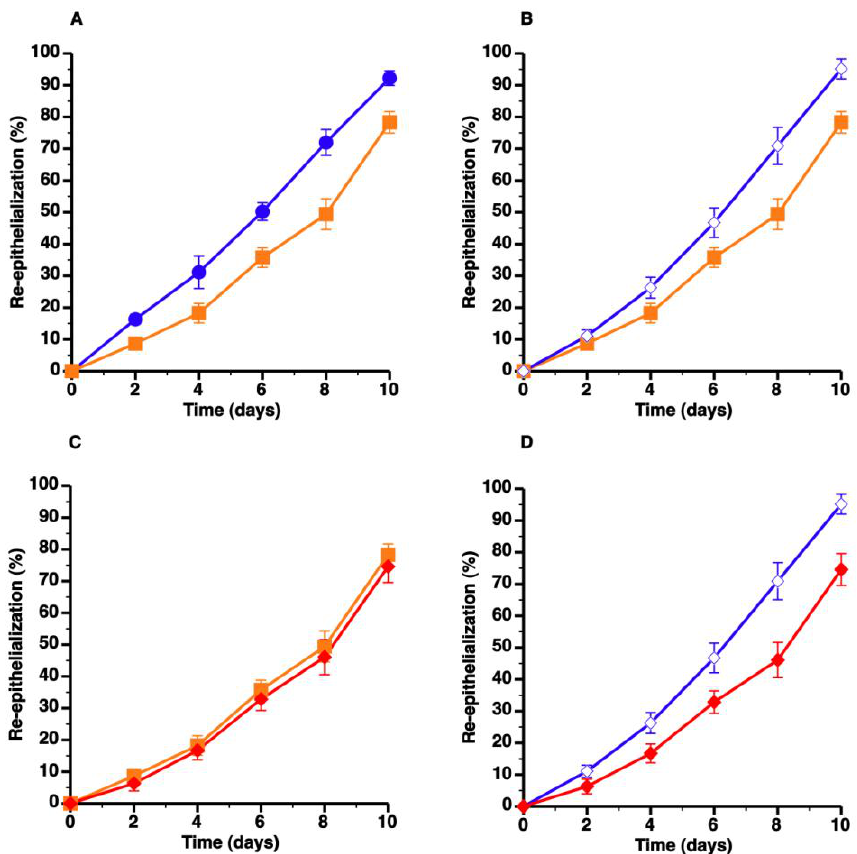
Figure 3. Topical HDL therapy corrects delayed wound healing in C57BL/6 apoE −/− mice.